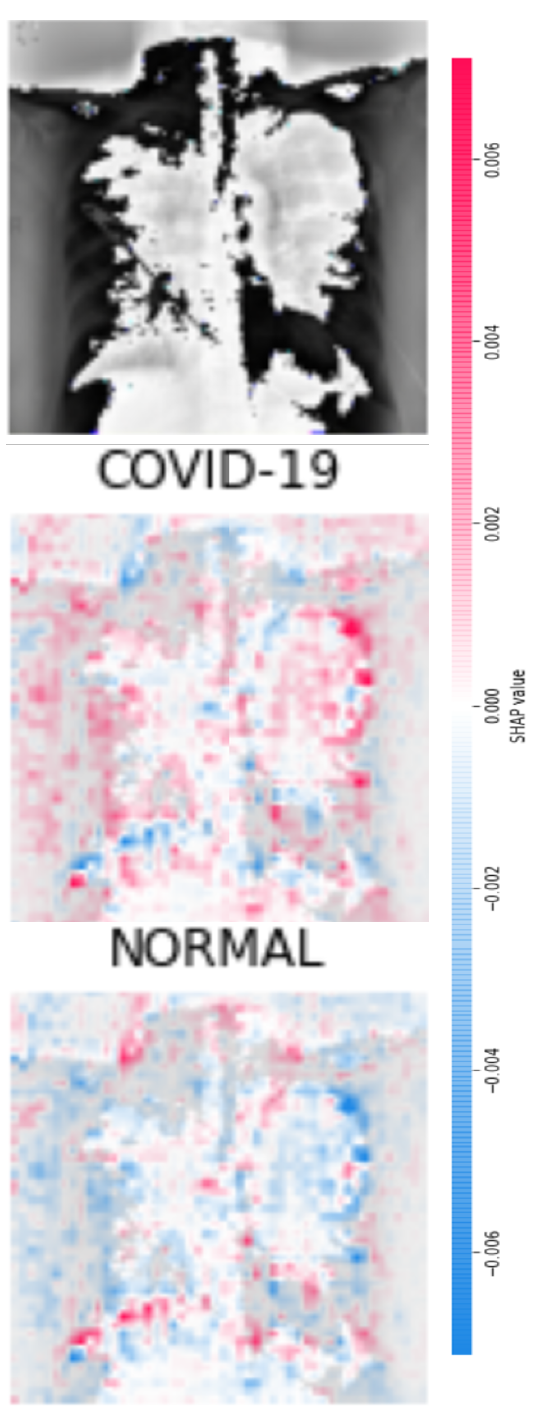
Figure 10. SHAP scores for the image displayed in Figure 8